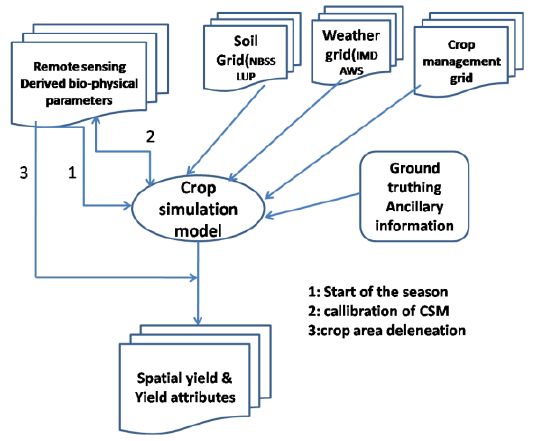
Figure 1. Flowchart of methodology